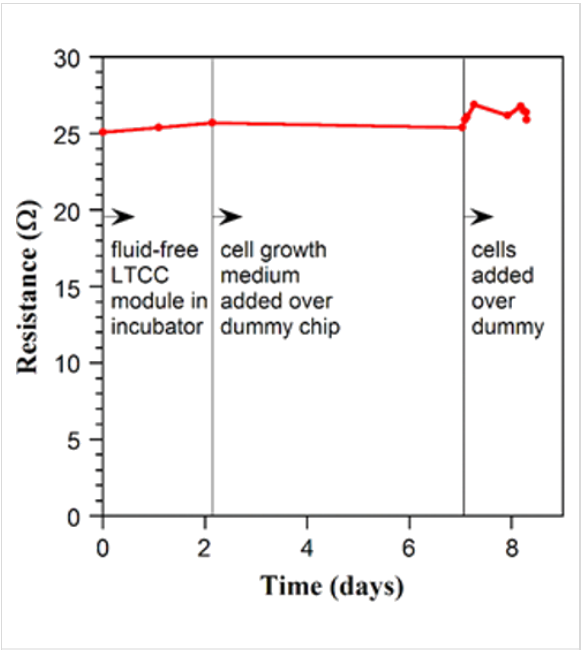
Figure 4: The total resistance of an LTCC packaged dummy chip placed in a cell culture incubator before and after cell growth media and BEAS2B cells were added onto the